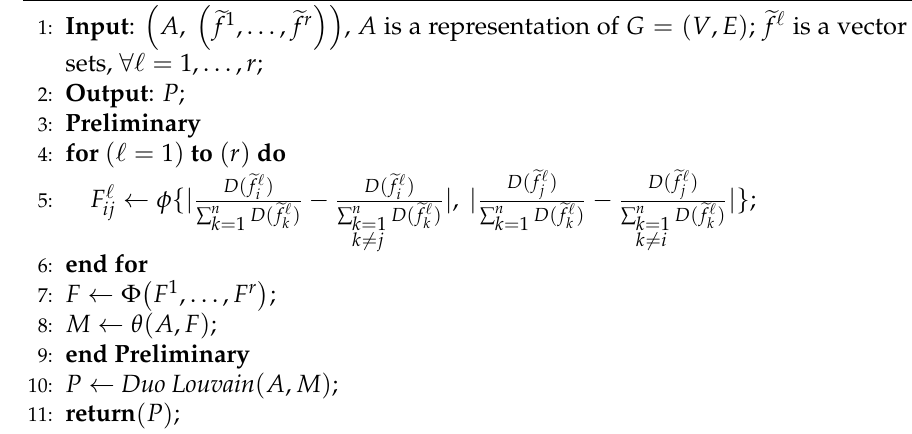
Algorithm 3 1-additive Multi-dimensional Sugeno–Louvain